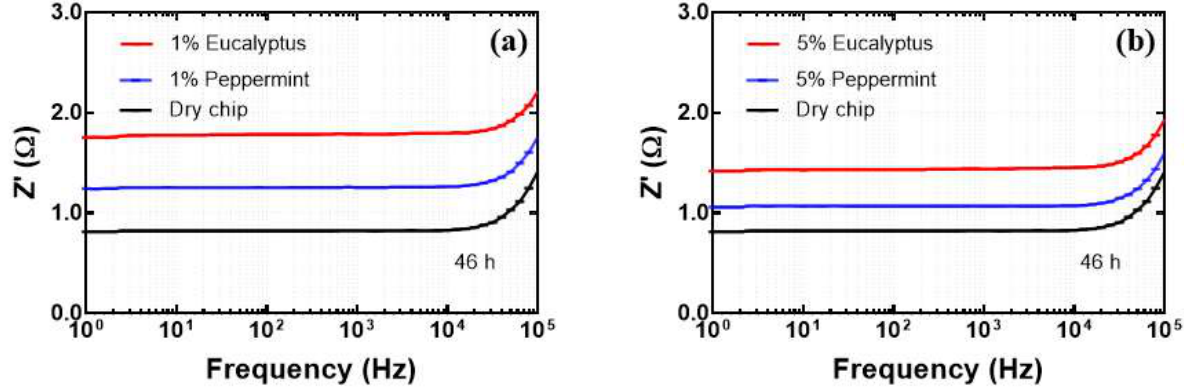
Figure 6. Change in resistance of fabricated microfluidic chip under the influence of ( a ) 1% and ( b ) 5% EOs solutions after 46 h of exposure. ( b ) 5% EOs solutions after 46 h of